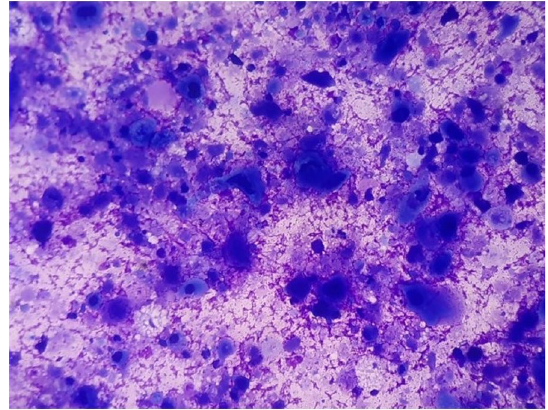
Fig. 3 FNAC from skin nodule s/o metastatic squamous cell